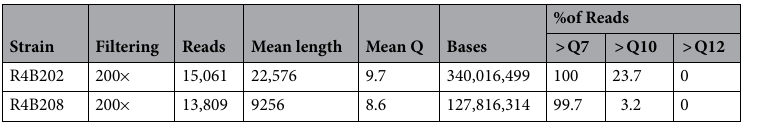
Strain Filtering Reads